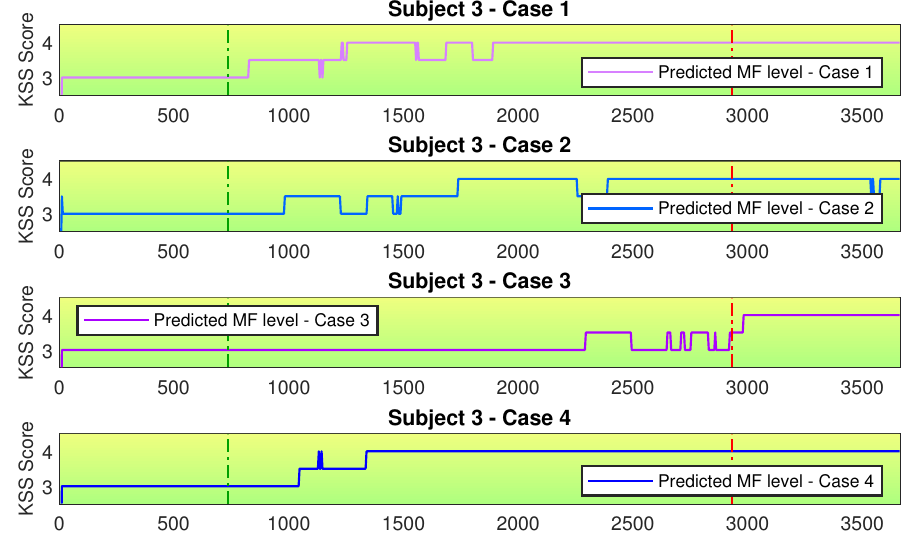
Figure 10. MF assessment for different cases for Subject 3. The horizontal axis is presented in seconds. The vertical green dashed line marks the superior limit of the data used for training the non-fatigue condition. The vertical red dashed line marks the inferior limit of the data used for training the fatigue condition. Case 3 produced a sharp transition between the fatigue and non-fatigue states. The addition of other sensors data helps with producing a smoother transition